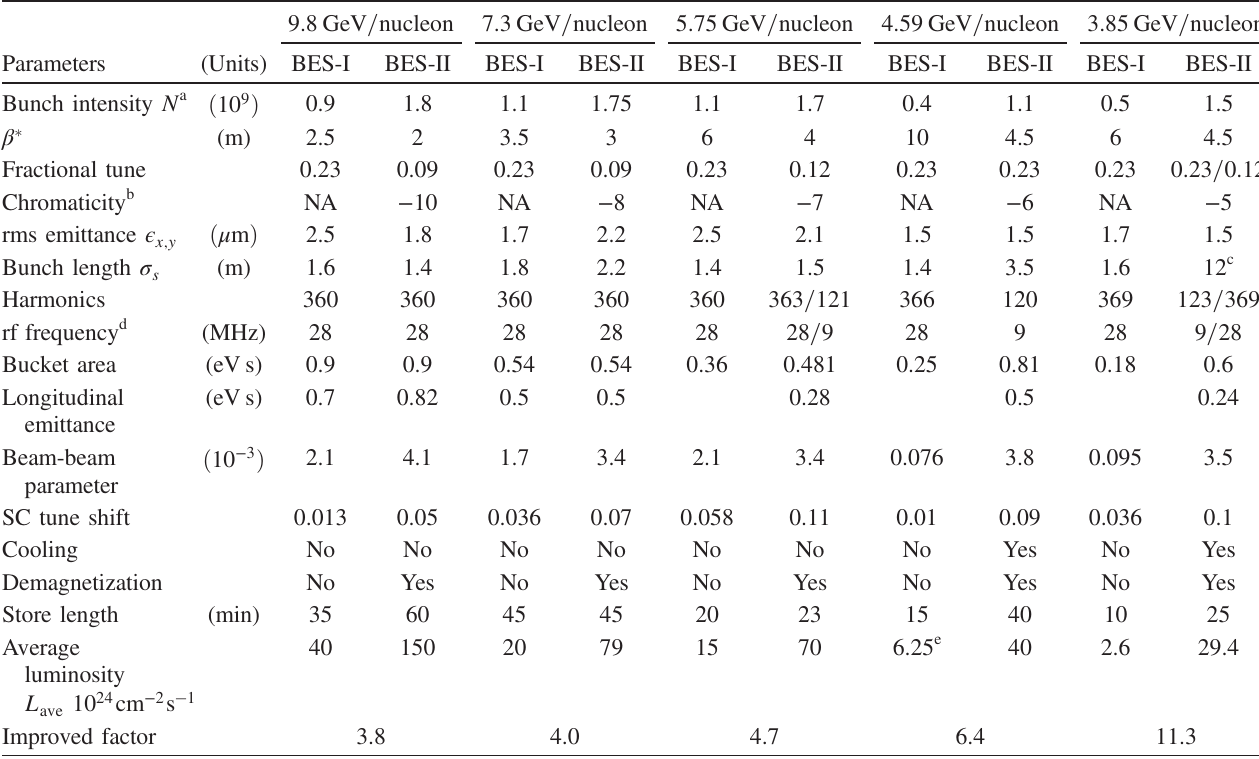
TABLE I. Beam parameters for BES-I and BES-II at various